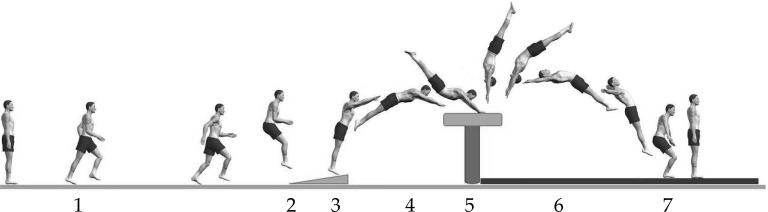
Vault seven phases (Prassas, 2002; 2006; Čuk, Karácsony, 2004; Takei, 2007; Ferkolj, 2010, Atiković and Smajlović, 2011). Vault phases: 1-run, 2-jump on springboard, 3-springboard support phase, 4-first flight phase, 5-support on the table, 6-second flight phase, 7-landing.